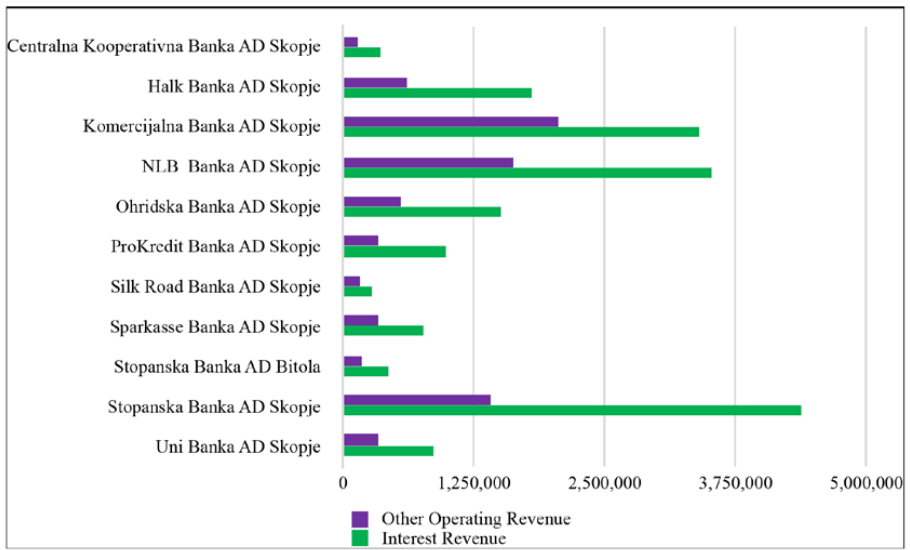
Figure A3. Mean for the outputs for each bank.